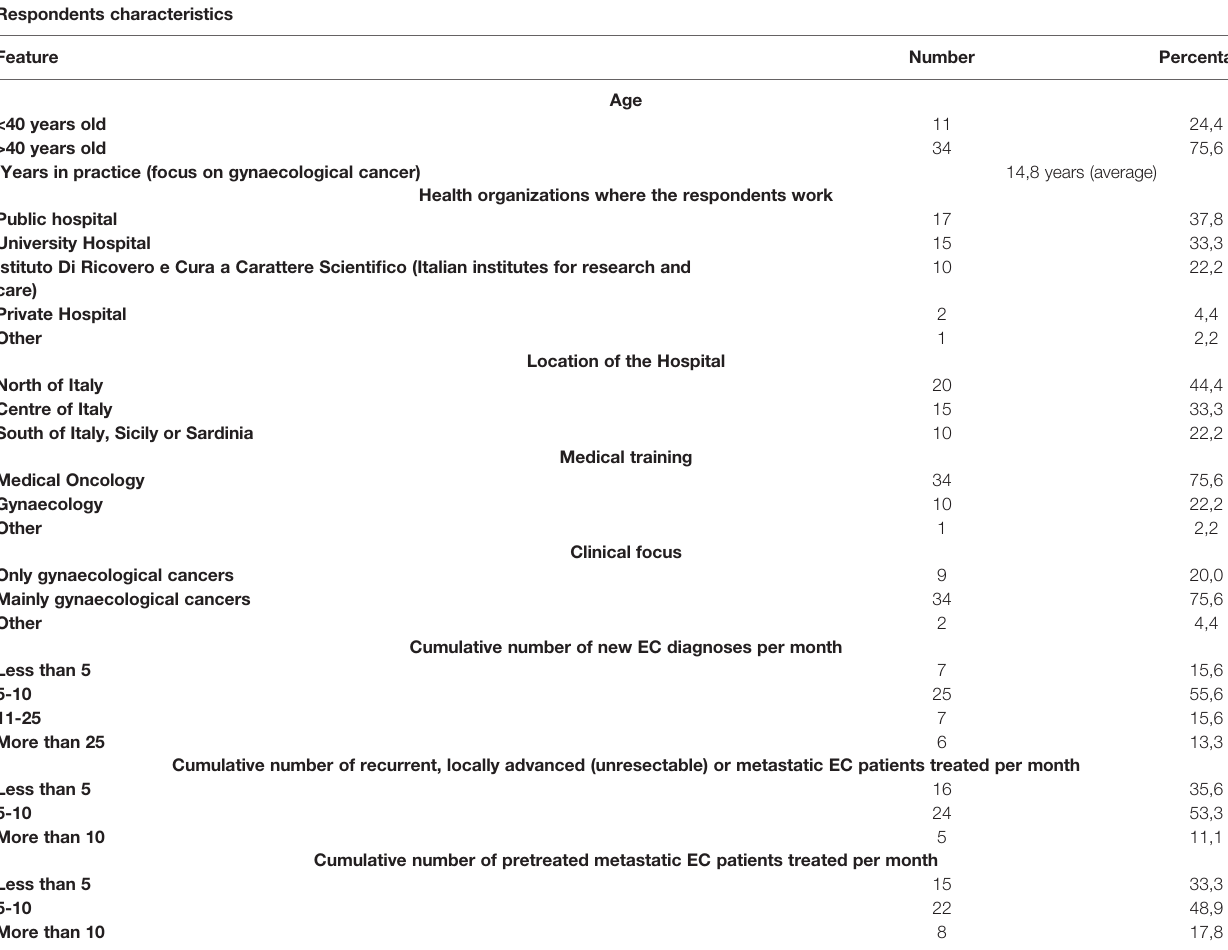
TABLE 1 | Respondents ’ characteristics.